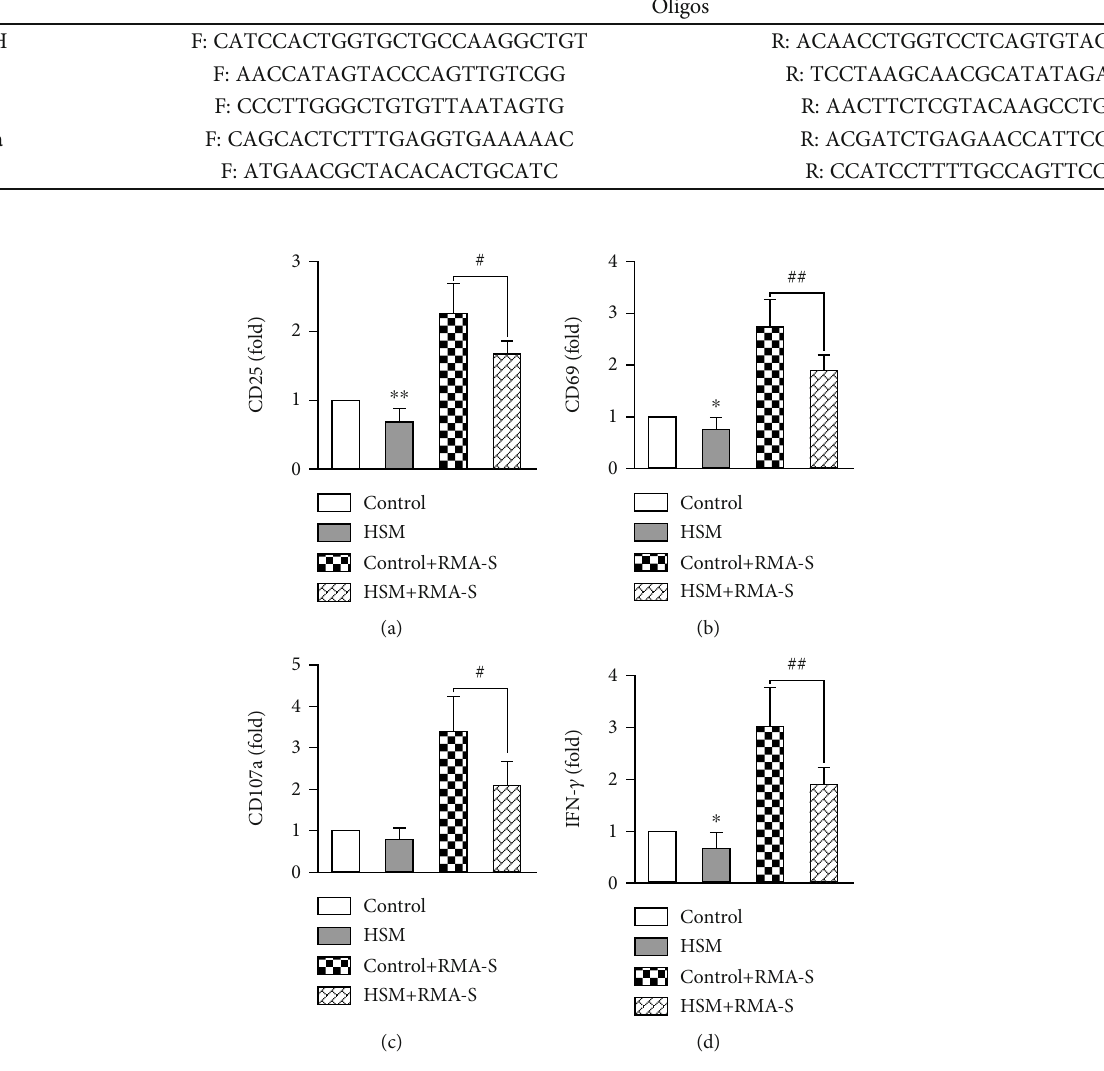
Figure 1: The genes encoding activation and functional markers of NK cells are downregulated following culture in high-salt medium. Mouse splenic NK cells were sorted by FACS and cultured in normal or high-salt medium with or without coculture with RMA-S. Quantitative reverse transcription-PCR (RT-qPCR) was used to analyze the mRNA levels of the activation genes, CD25 (a) and CD69 (b), and the functional genes, CD107a (c) and IFN- γ (d), in NK cells. Data represent at least three independent experiments and are shown as the mean ± SEM . Unpaired Student ’ s t -test (two-tailed) was performed using the Prism software. A P value < 0.05 was considered signi fi